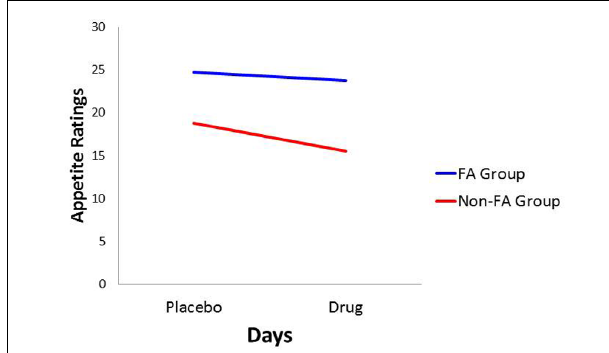
In conformance with statistical convention, the absence of a significant interaction between the food-addiction and non-food- addiction variable and the placebo vs. drug variable precludes the legitimate testing of post hoc individual-Group comparisons across Days. It is important to note, however, that this interac- tion is testing the significance of the difference in slopes between the two groups. It is not testing whether either slope is different from zero. In this case, a slope not different from zero indi- cates no drug-suppression effect. Since the primary question of interest in the current study was whether one or both of the food-addiction groups displayed a suppression effect – not simply whether they differed from each other – a test of simple slopes was carried out for each group, strictly acknowledging that the results are investigational and preliminary. In the non-food-addiction FIGURE 4 | Plot for the Sex main effect with percentage of snack-food group, the decrease from the placebo to the methylphenidate consumption as the dependent variable. condition for appetite ratings and food cravings was statisti- = 0.260 cally significant in both instances ( p < 0.0001: η 2 p food-intake in the drug condition from the placebo and 0.1.86, respectively). In the food-addiction group, neither comparison was statistically significant ( p = 0.257 and 0.198, respectively).